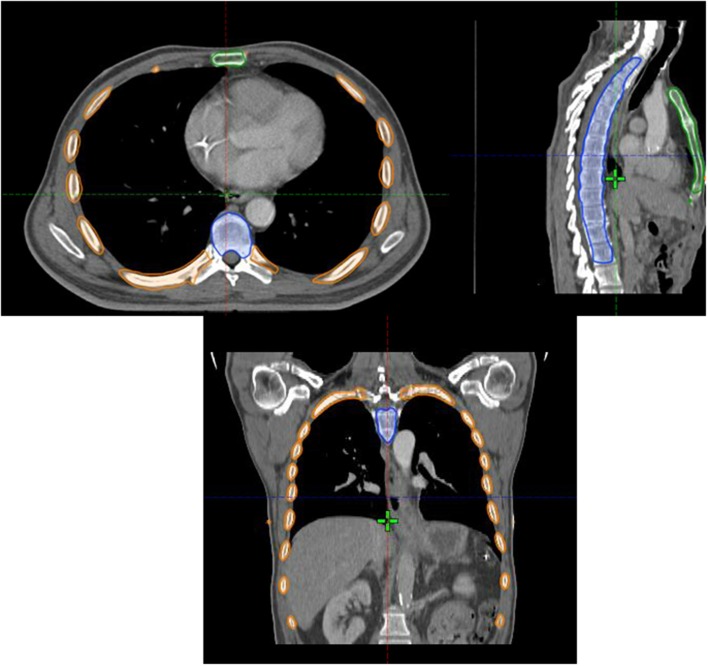
Axial (top left), sagittal (top right) and coronal (bottom) images of the thoracic marrow structure comprised of the sternum (green contour), ribs (orange contour), and vertebral bodies from T1-L1 (blue contour).